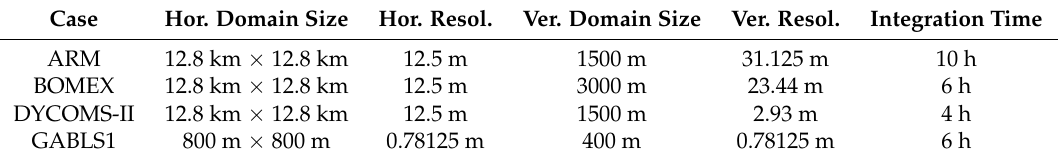
Table 1. Horizontal and vertical domain size, horizontal and vertical resolution, and integration time for the LES runs. Case Hor. Domain Size Hor. Resol. Ver. Domain Size Ver.